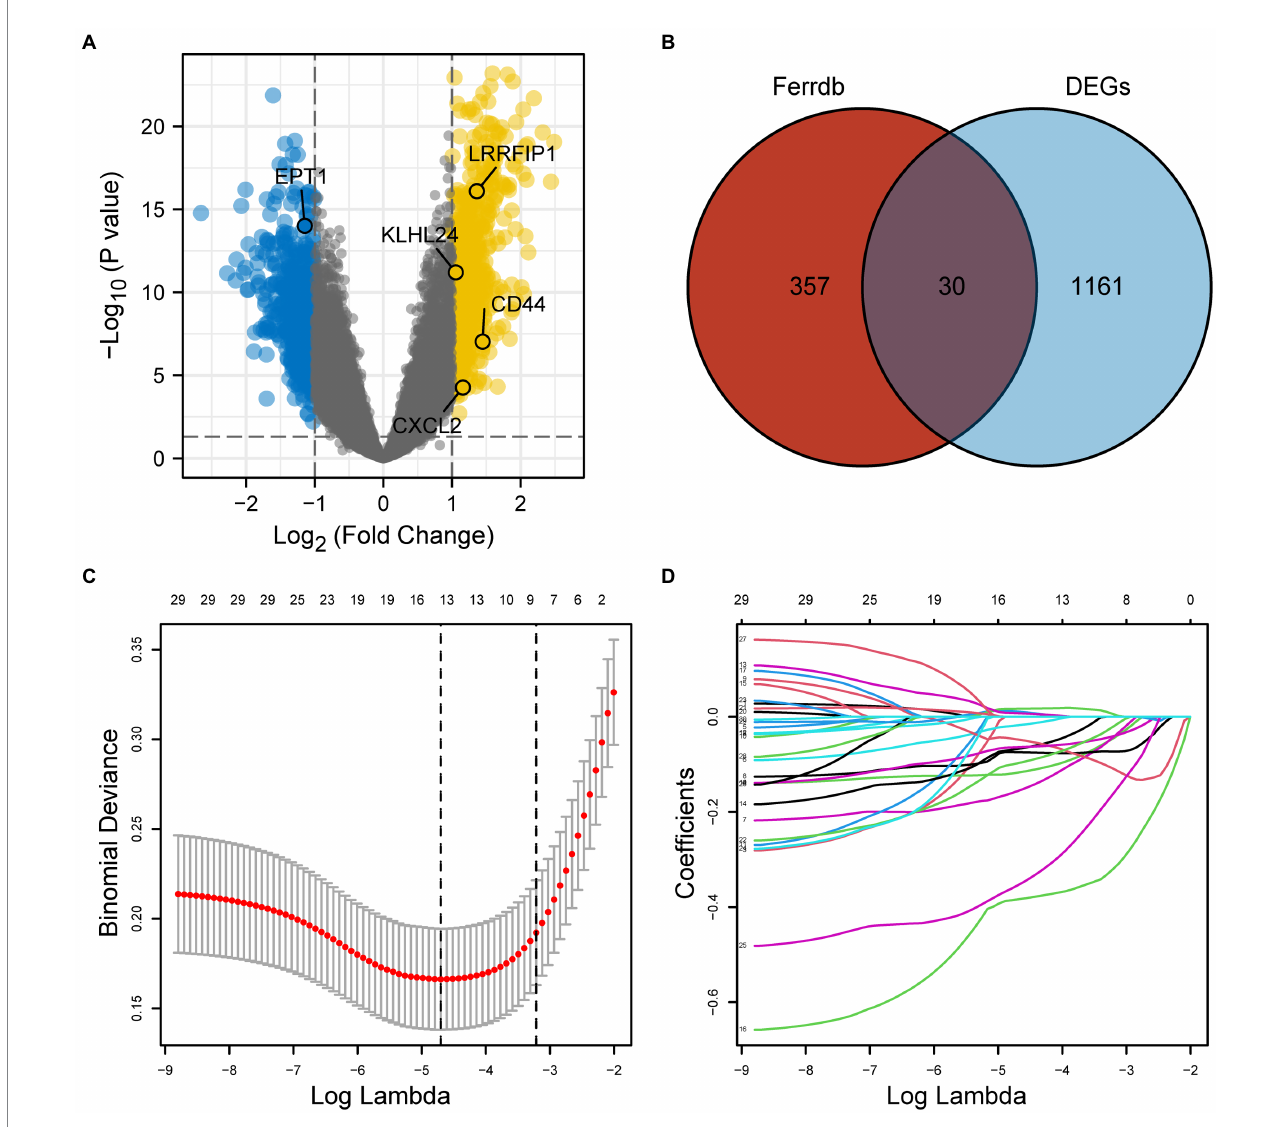
FIGURE 2 (A) Differentially expressed genes (DEGs) between the AD and control samples of GSE5281 ( p < 0.05, with |log (FC)| > 1). (B) A total of 30 overlapping FRGs obtained from DEGs and 387 FRGs downloaded from FerrDb. (C) LASSO model. (D) The variation trajectory of each independent variable. DEGs, differentially expressed genes; FRGs, ferroptosis-related genes; AD, Alzheimer’s